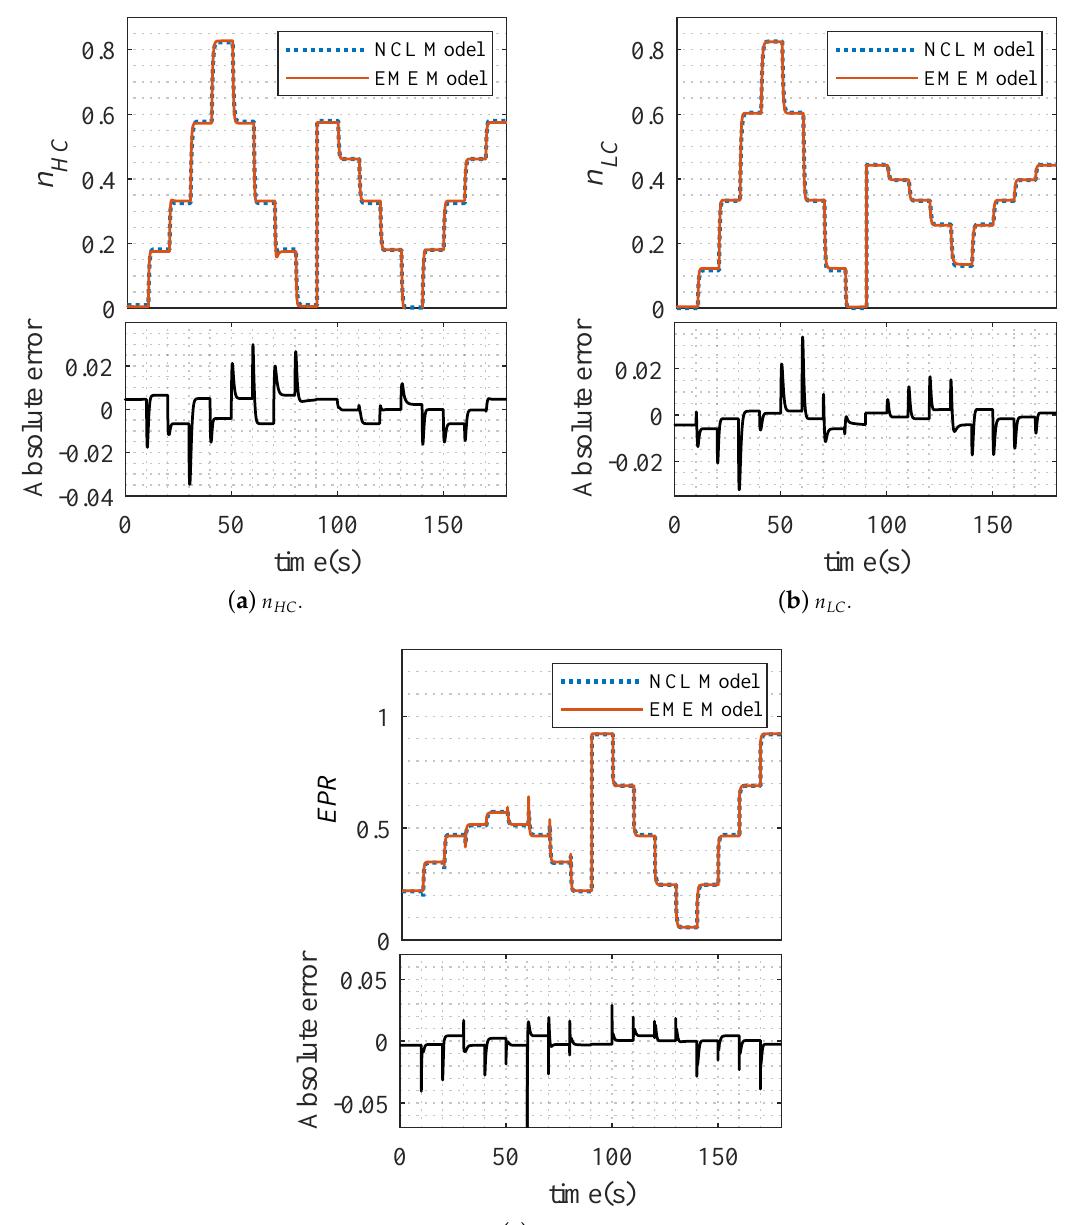
(cid:104) (cid:105) W f , A n )